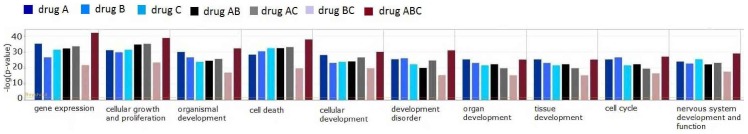
The Top 10 bio-functions analyzed by ingenuity pathway analysis ingenuity system (IPA).